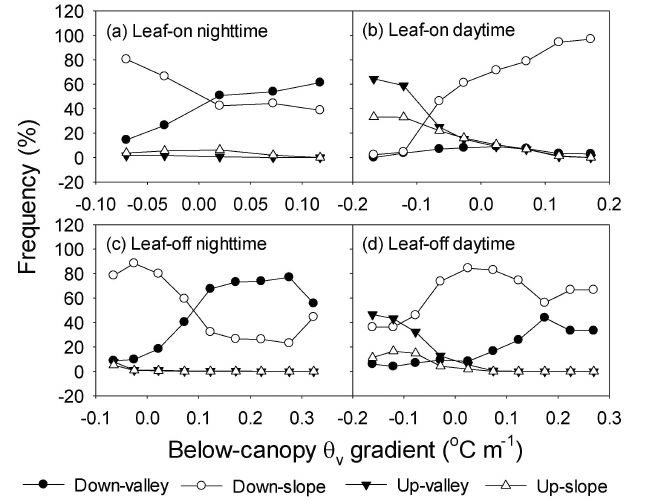
Figure 13. Change of the relative frequency of mean wind direction sector at the 2 m with the gradient of below-canopy virtual potential air temperatu re (θ v ) in 2012. ( a ) nighttime for leaf-on season, ( b ) daytime leaf-on season, ( c ) nighttime for leaf-off season, and ( d ) daytime for leaf-off season.